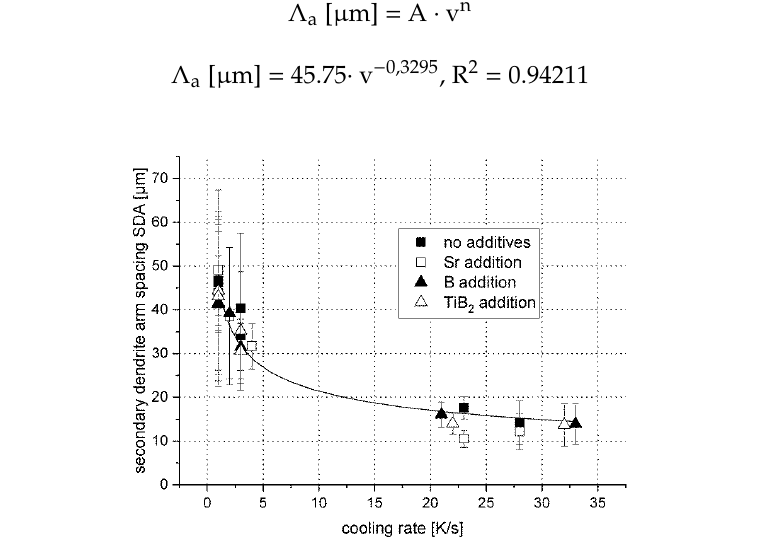
Figure 7. Measured values for secondary dendrite arm spacing (SDA) and cooling rate and fit curve based on Sahm’s equation (Equation (4), [71]).